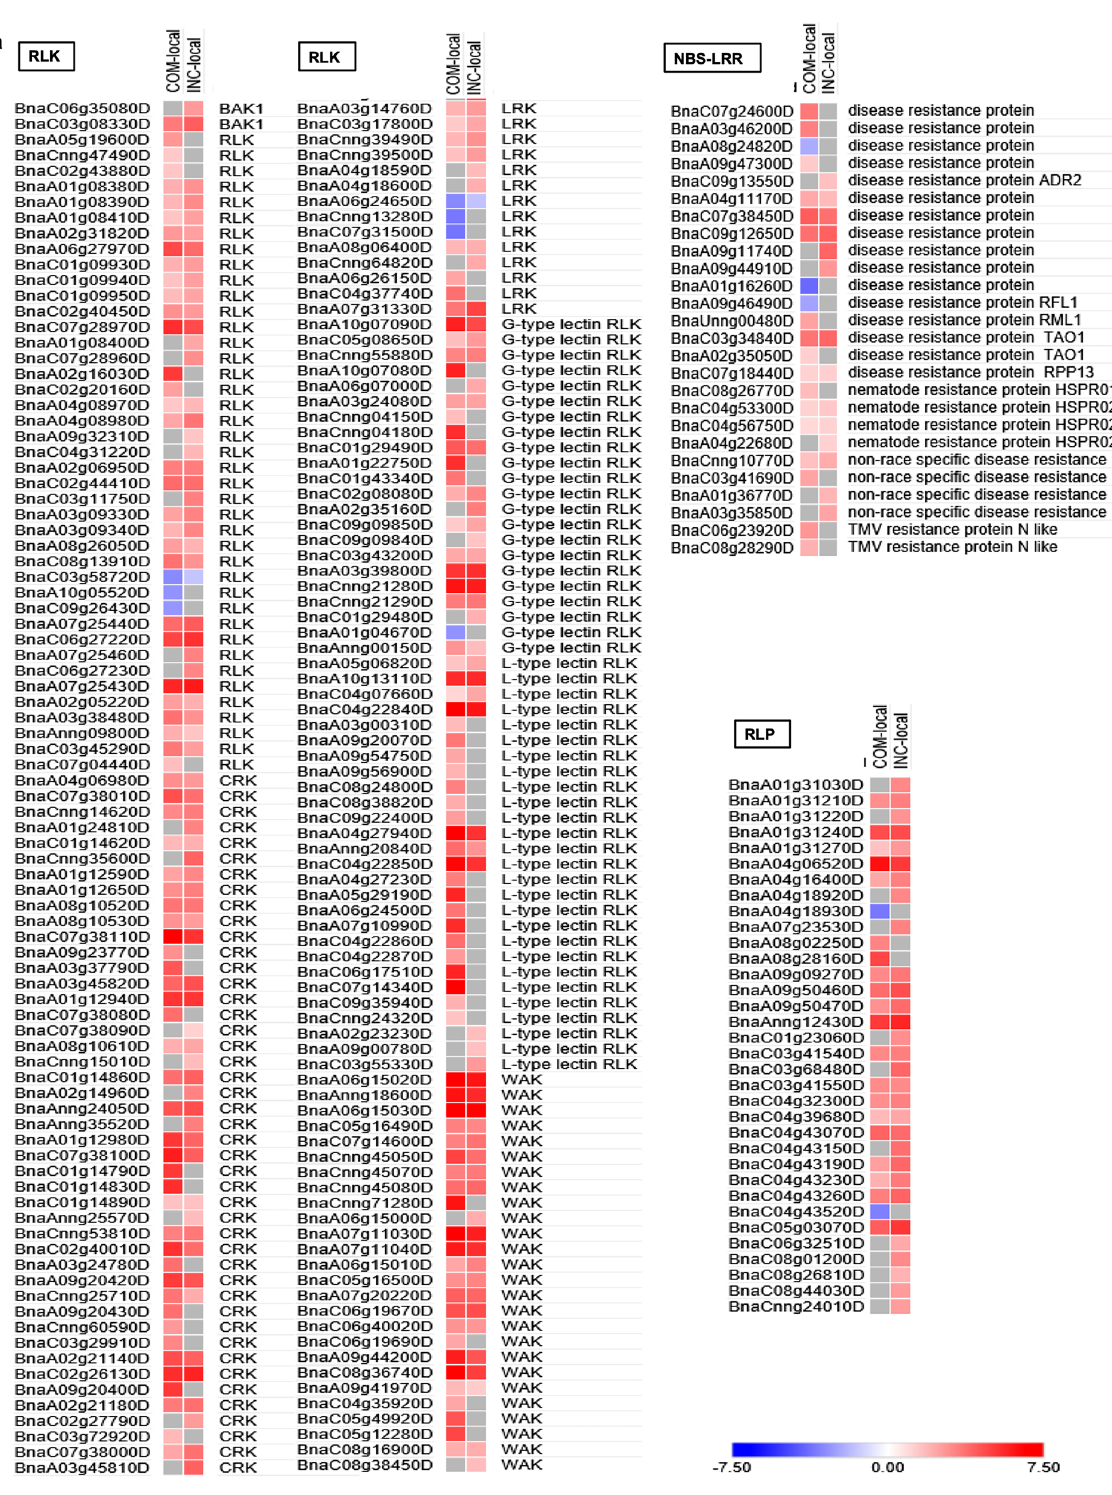
Figure 6. Heat map illustration of the core genes involved in the defense network against Lm infection. ( a ) DEGs encoding RLKs, NBS-LRRs and RLPs. ( b ) DEGs involved in phytohormone pathways. ( c ) DEGs encoding WRKY TFs. ( d ) DEGs encoding PR proteins. The colour bar represents values of log 2 -fold changes ranging from − 7.5 (blue) to 7.5